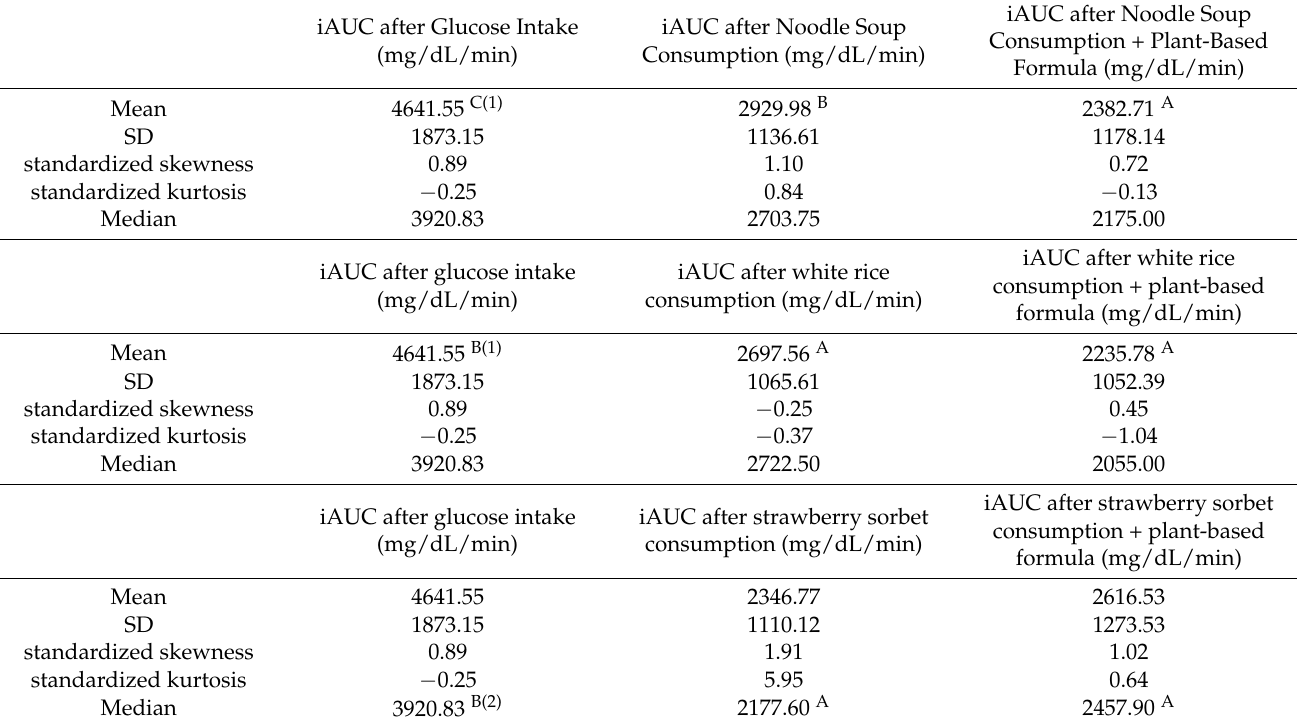
Table 4. The area under the postprandial glycemic curve (iAUC) values ( n = 23). iAUC after Glucose Intake iAUC after Noodle Soup (mg/dL/min) Consumption